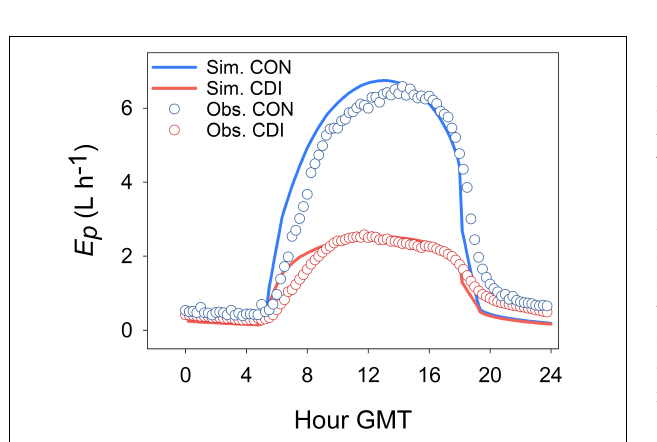
FIGURE 4 | Daily course of simulated and observed transpiration ( E p ) in a typical sunny summer day (July 21st 2006, DOY 202) for the control (CON) and continuous deficit irrigation (CDI) treatments of Experiment